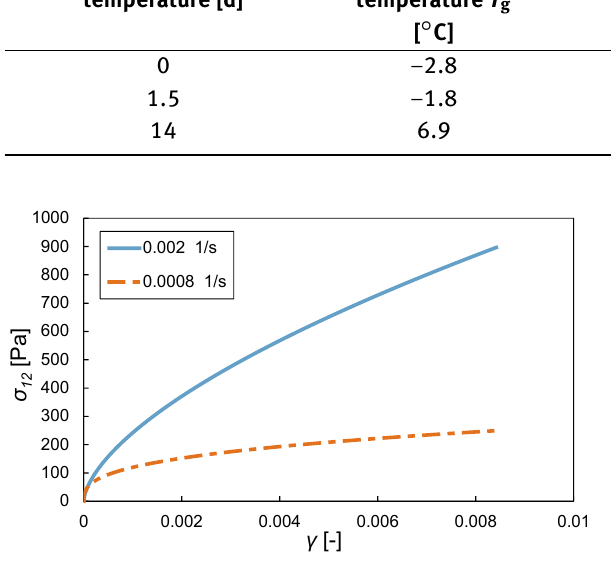
Figure 2: Results – Thin Plate Torsion Test: longitudinal shear stress σ 12 vs. shear strain 𝛾 for two different shear